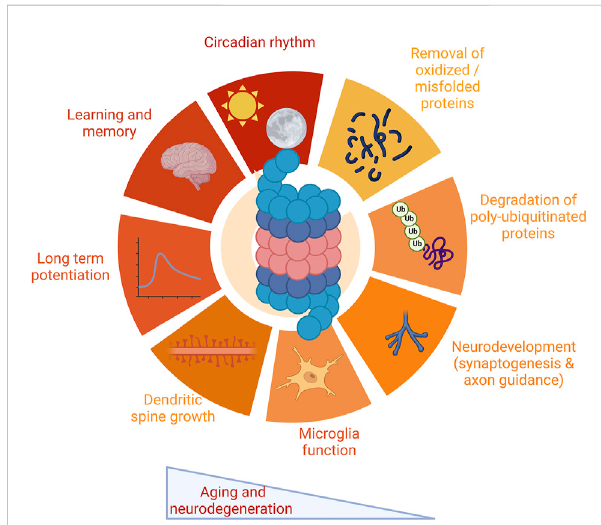
FIGURE 1 Multiple functions of the proteasome in the nervous system. The proteasome plays critical roles in a wide range of functions critical to the nervous system. These include protein degradation, both of oxidized and misfolded proteins as well as degradation of polyubiquitinated proteins. The proteasome impacts a range of functions speci fi c to the nervous system, including synaptic physiology and plasticity, neurodevelopment and glial cell function, and maintenance of circadian rhythm. The proteasome modulates learningandmemory.Proteasomeimpairmentisarobustfeatureboth of aging and neurodegenerative disease, leading to dysfunction in these pathways. Images Created with